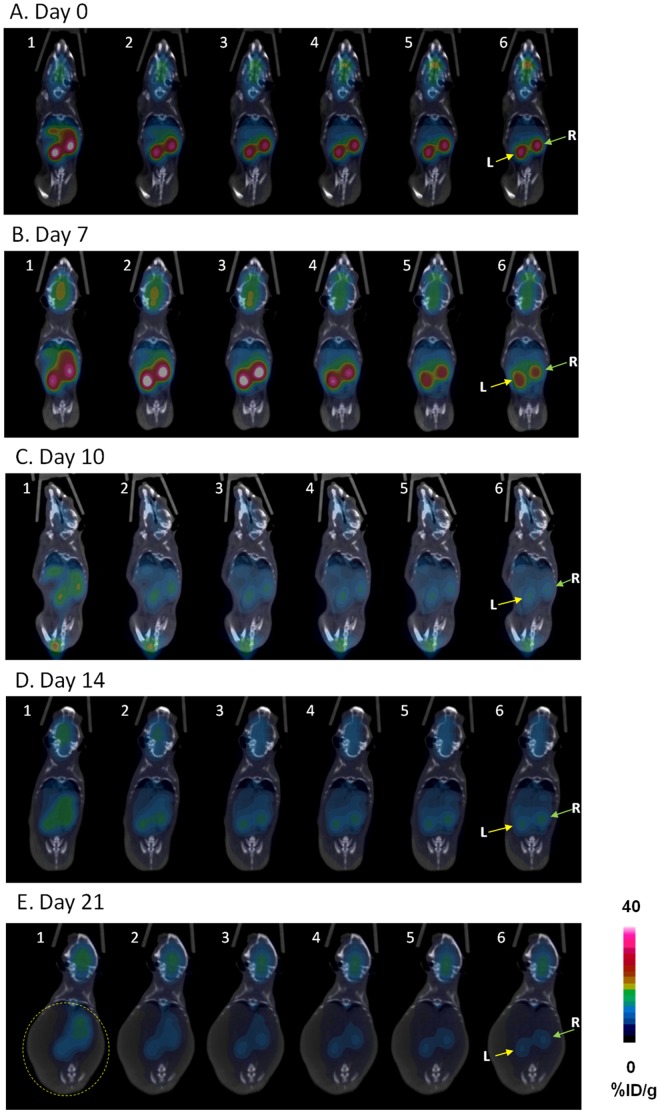
Representative coronal PET-CT images of mice following FDG injection.Images were obtained 0 (A), 7 (B), 10 (C), 14 (D) and 21 days (E) post-administration of rabbit IgG injection. They were derived from the 0–60 min dynamic scans (5 min per frame and 12 frames in total). L: left kidney; R: right kidney. The yellow dashed circle delineates the substantial enlargement of the abdominal cavity on day 21.